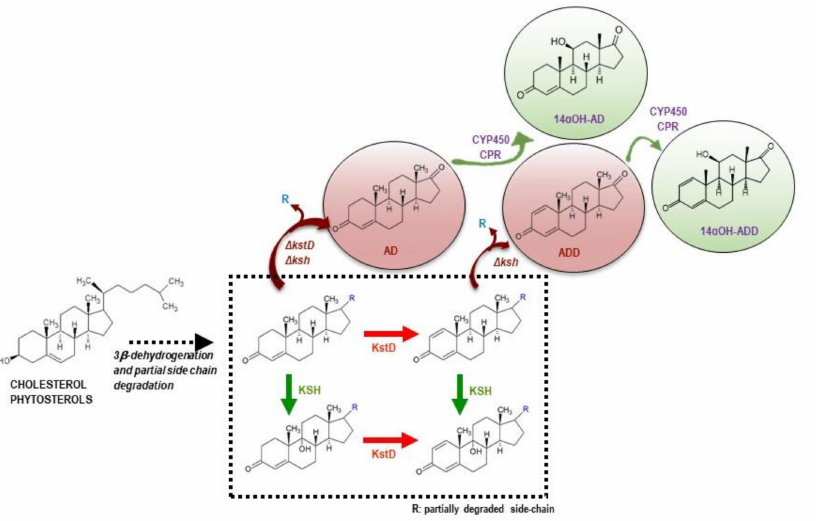
Figure 2. Scheme of the rational construction of mycobacterial strains producing hydroxylated steroidal intermediates from natural sterols by incorporating the hydroxylating system from C. lunatus . kstD , 3-ketosteroid- ∆ 1 -dehydrogenase; ksh , 3-ketosteroid-9 α